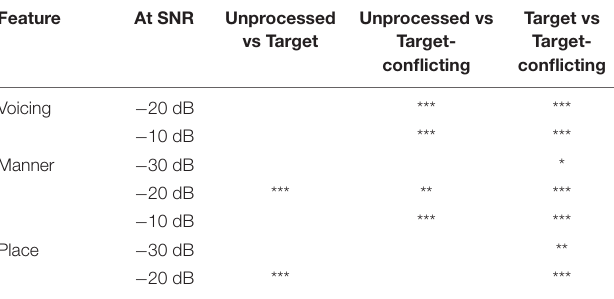
TABLE 4 | Pairwise multiple comparisons between the signal processing conditions for voicing, manner, and place.